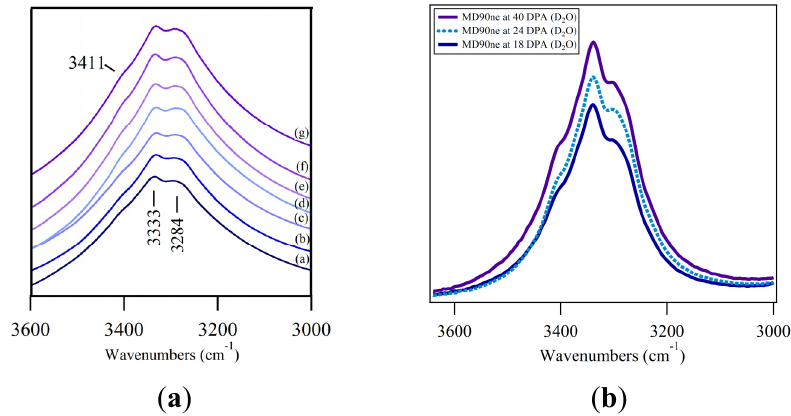
Figure 2. ( a ) FTIR spectra of the hydrogen-bonded O-H stretching region for cotton fibers harvested at different DPA: (a) 18 DPA; (b) 20 DPA; (c) 24 DPA; (d) 28 DPA; (e) 32 DPA; (f) 36 DPA; and (g) 40 DPA; ( b ) O–H stretching region for deuterated 18 DPA (bottom), 24 DPA (middle), and 40 DPA (top)